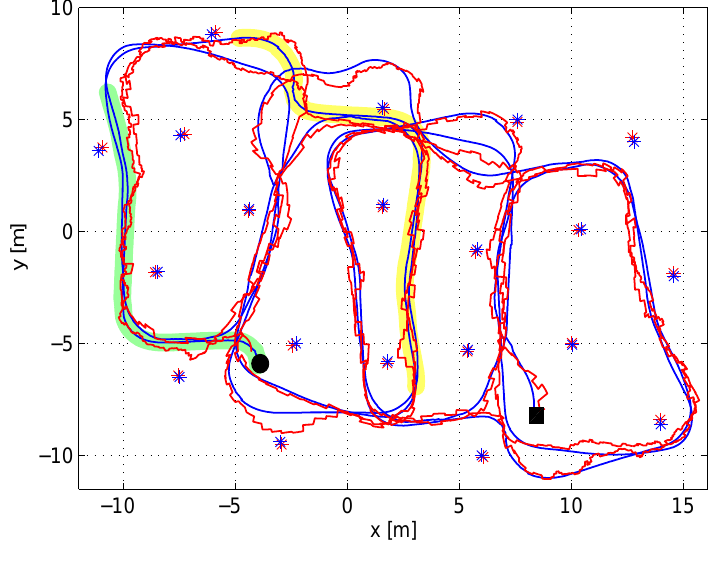
Figure 10. Results of the proposed SLAM scheme in one experiment. Estimations are in red and the ground-truth in blue.